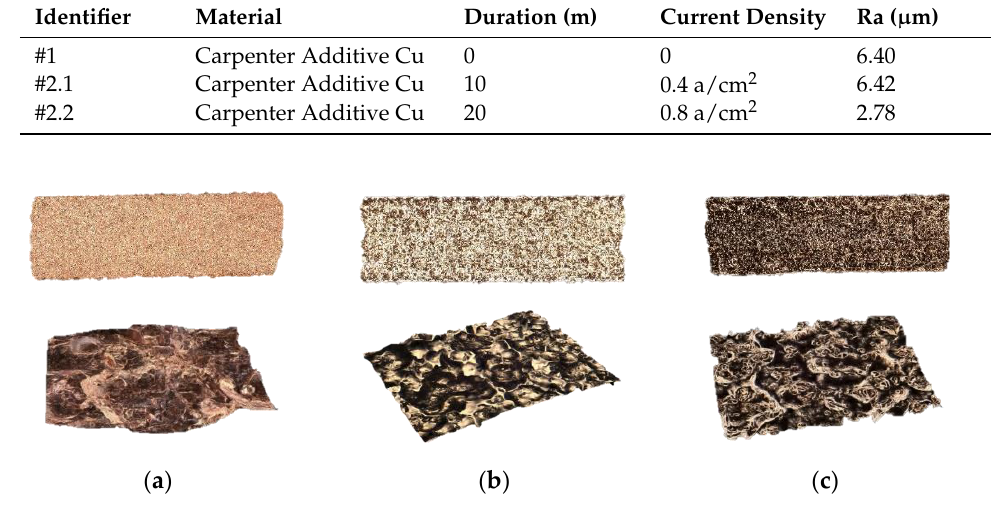
Table 7. Surface roughness of L-PBF as built and electropolished copper.